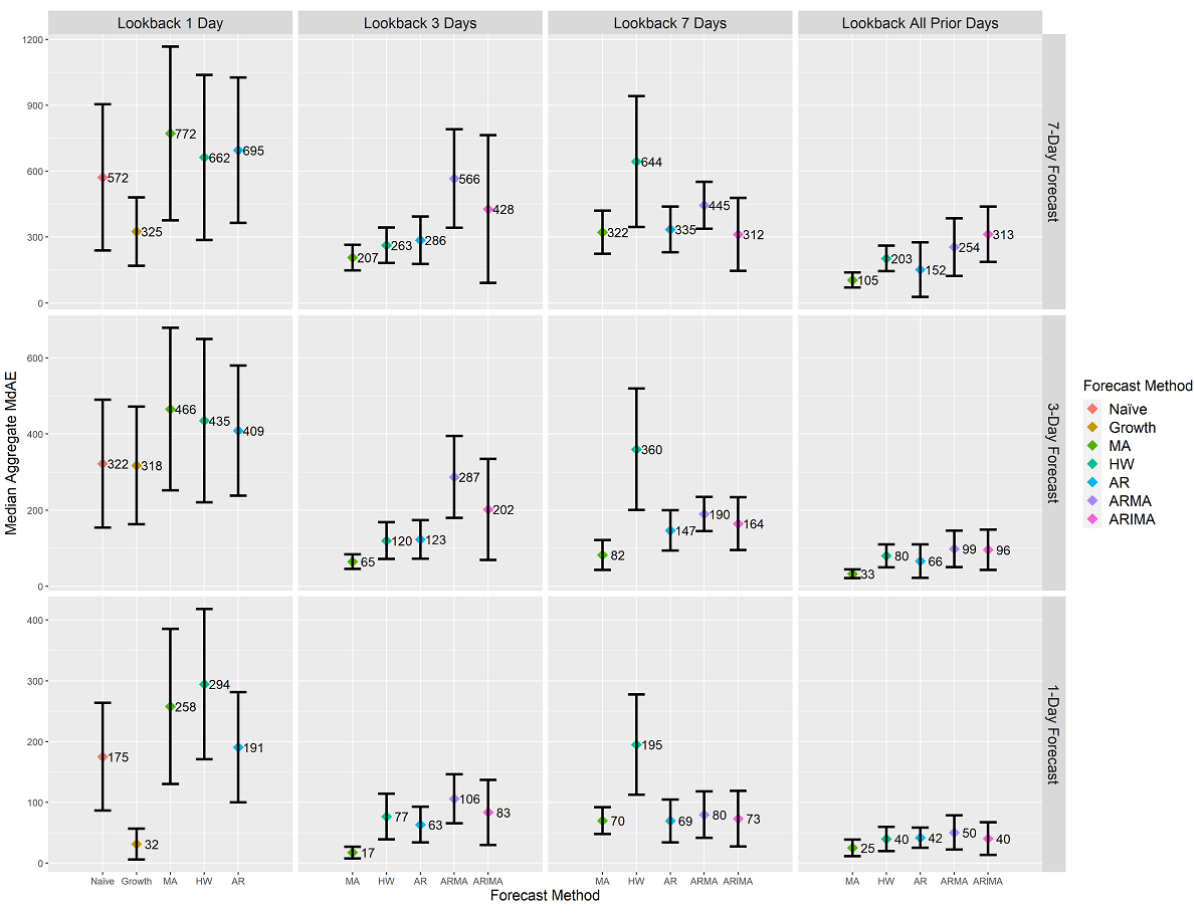
Figure 4. State-level forecasts’aggregated median MdAE values and 95% CI. CI ranges are calculated using box plot notch ranges around the median. Statistically significant differences at a P value of .01 are identified by nonoverlapping CI ranges of forecasting methods at each combination of forecast length and look-back length. Units are in terms of COVID-19 cumulative case counts. Y-axis scales differ on each row based on the scale of the contained data. Due to differing assumptions, five of the seven forecasting methods are present for each look-back length as indicated on the x-axis. AR: autoregressive; ARIMA: autoregressive integrated moving average; ARMA: autoregressive moving average; HW: Holt-Winters; MA: moving average; MdAE: median absolute